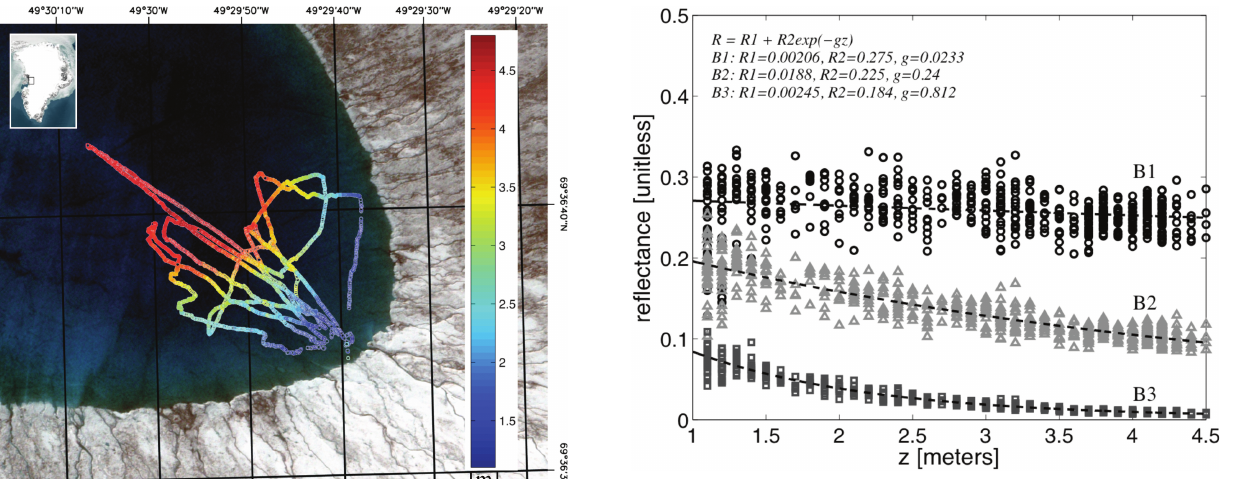
Fig. 3. In-situ measured water-leaving reflectance values vs. lake depth for the Landsat bands 1, 2 and 3 and exponential